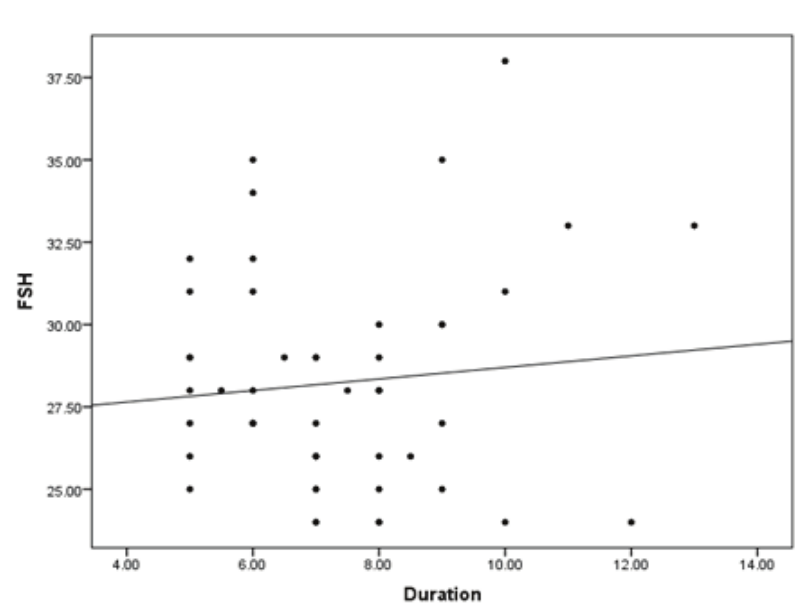
Figure 8 : Correlation of duration with FSH in case group ( R = 0.100, P =